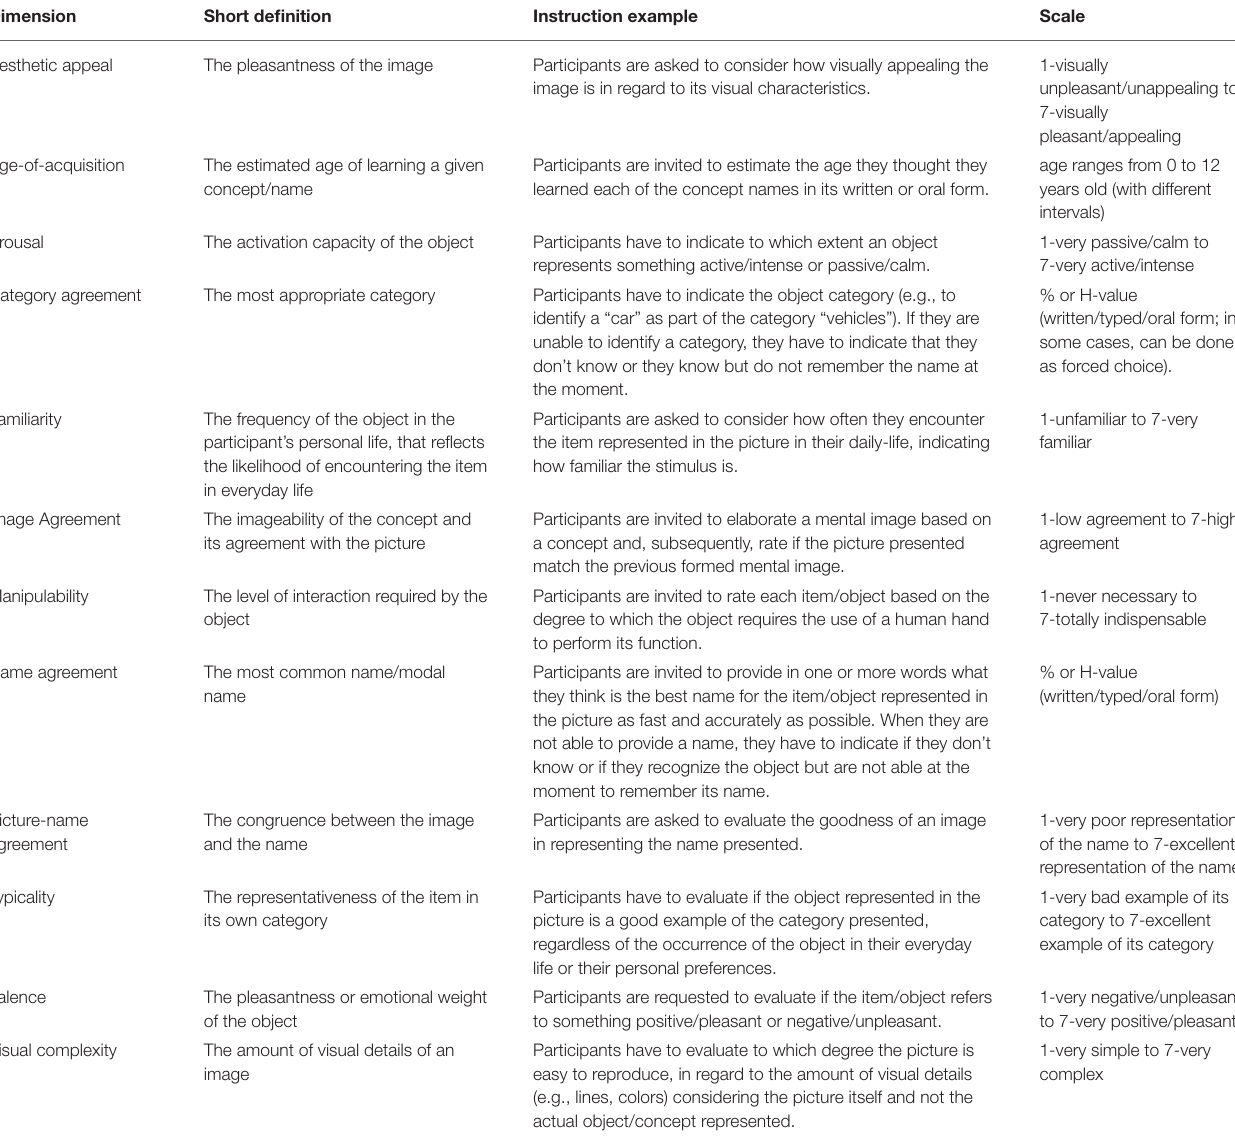
TABLE 2 | Generic definitions of relevant dimensions, examples of instructions and their